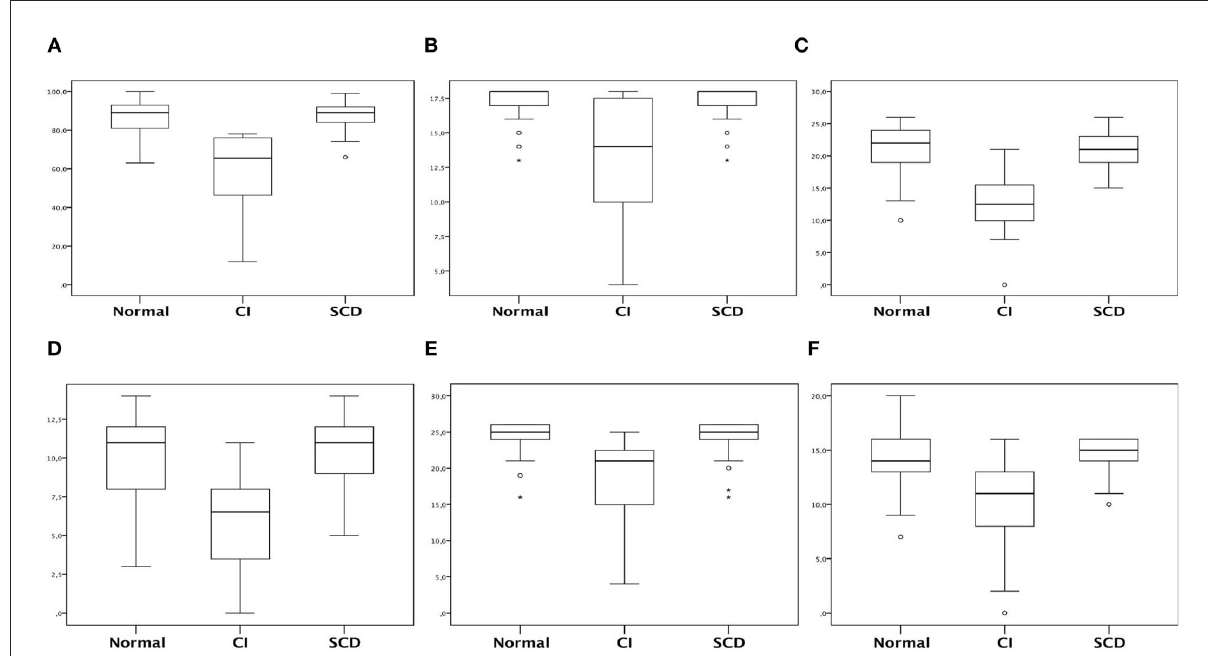
FIGURE3 Box-plot representing total ACE-R and subitens scores comparison in relation of patients cognitive status. (A) Total ACE-R; (B) Attention and orientation; (C) Memory; (D) Fluency; (E) Language; (F) Visuospatial. *Kruskal-Wallis test was applied with Dunn post-test. (A) p < 0.05 between CI vs. SCD and Normal. CI, coginitve impaired; SCD, subjective cognitive